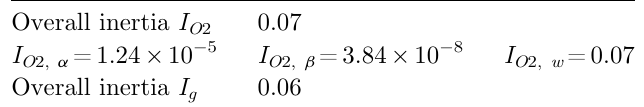
Table 2. Components of center of gravity of noise of measurement.